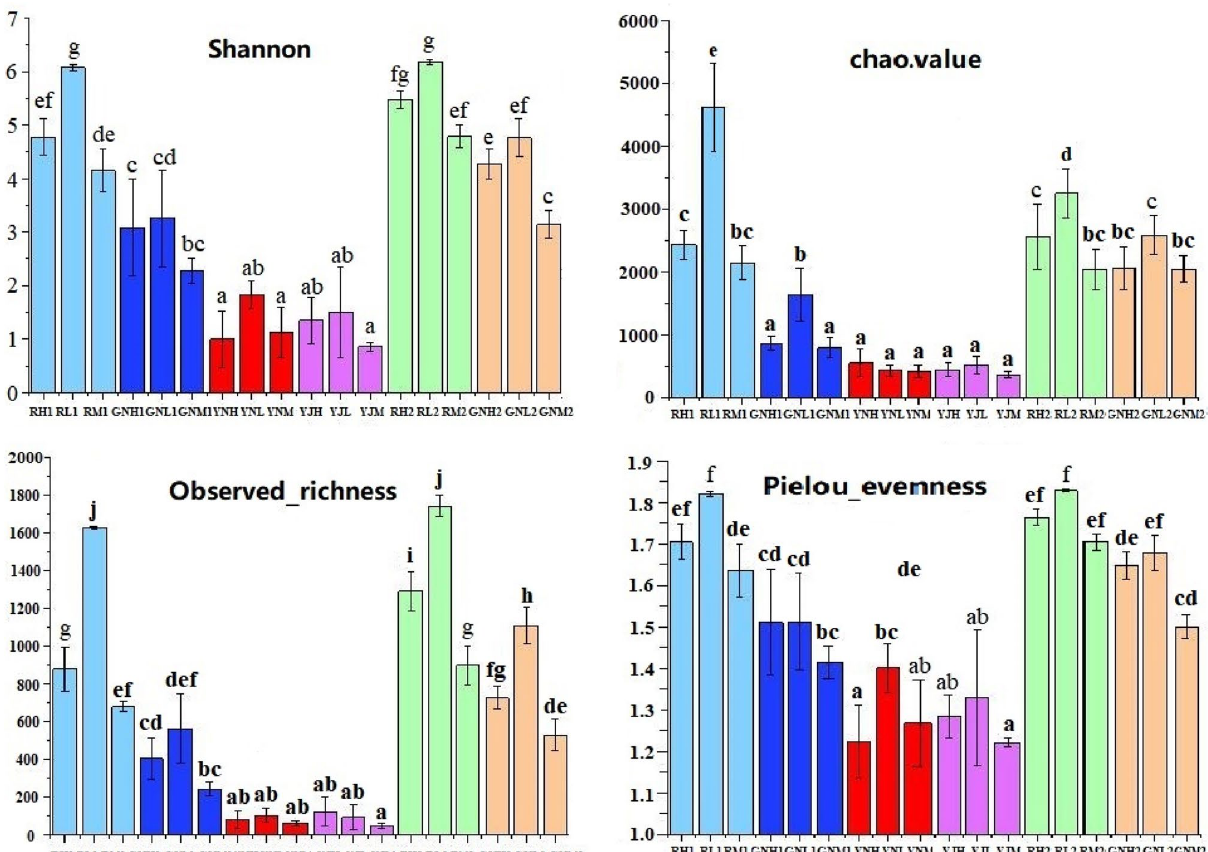
Figure 5. α-diversity of bacteria in root, rhizosphere, leaf and phyllosphere of rice at tillering and maturity stages. Notes: Different letters indicate the significant difference among bacteria of different soil